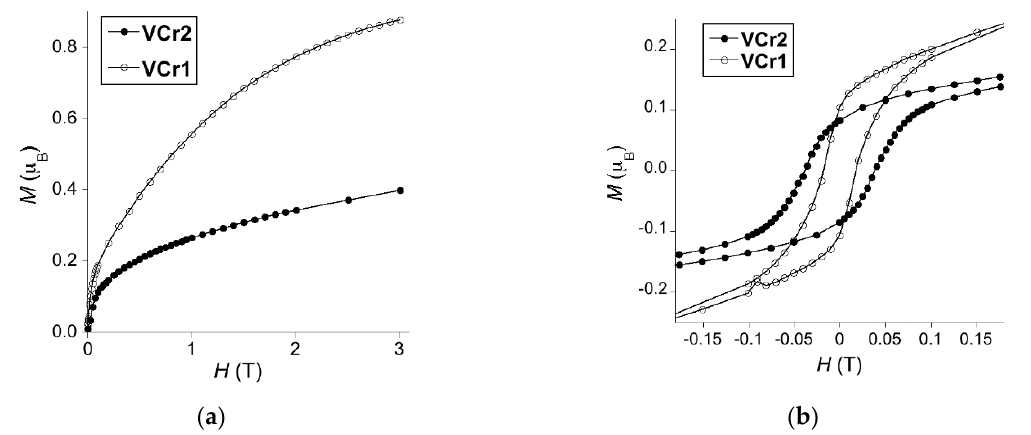
Figure 2. ( a ) Magnetization data and ( b ) hysteresis cycle for VCr1 (empty circles) and VCr2 (full circles) at 2 K.